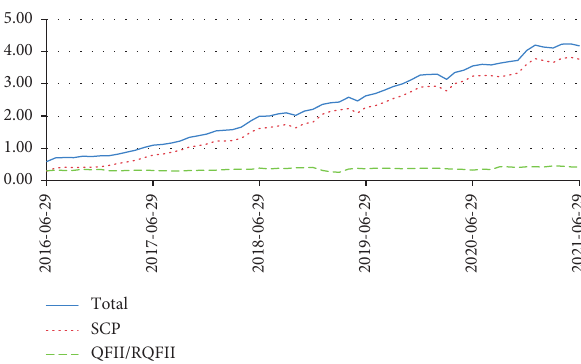
Figure 1: The holding share of foreign investors in A-share market from 29 June 2016 to 29 June 2021. The SCP refers to the foreign flows via the Stock Connect Program; QFII and RQFII refer to the Qualified Foreign Institutional Investors and RMB Qualified Foreign Institutional Investors,